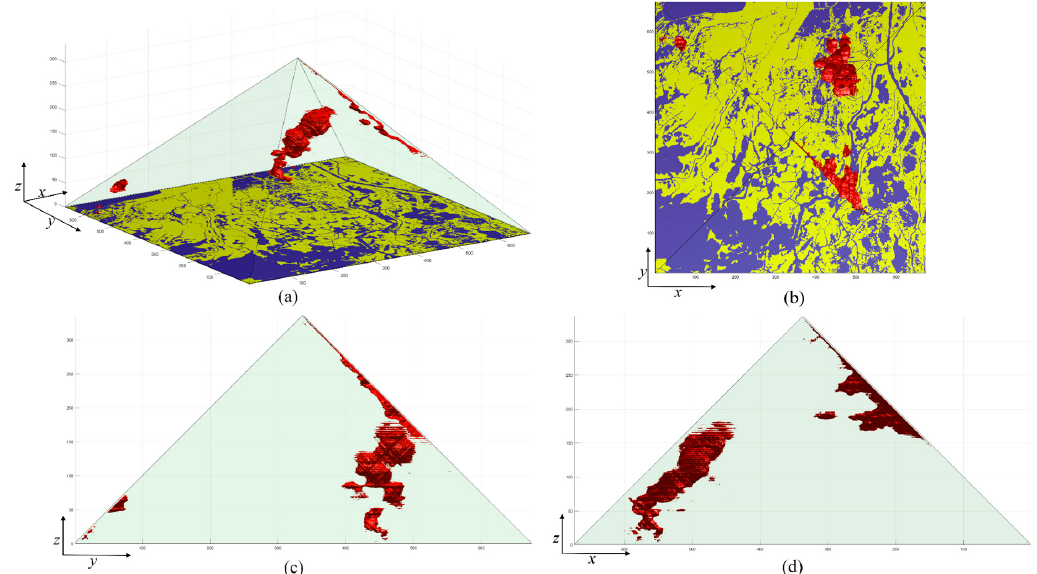
Figure 18. The isosurface of voxels with a 0.99 fractal dimension in the PM. ( a ) An oblique view. ( b ) A top-down view. ( c ) A horizontal view along the x axis (east). ( d ) A horizontal view along the y axis (north).